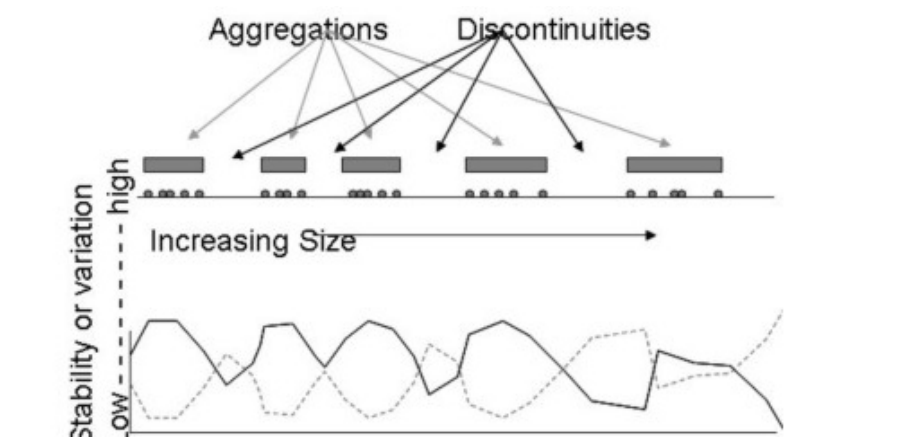
Fig. 4 . The relationship between discontinuities, variability and stability. Body size distributions of animals are characterized by aggregations and discontinuities (upper graphic, circles representing species). Aggregations reflect domains of scale and discontinuities reflect scale breaks. Within domains of scale, resource variation is low (lower graphic, dotted line), and at scale breaks resource variation is high. Stability (solid line) is inversely related to variability and is high within scales and low at scale